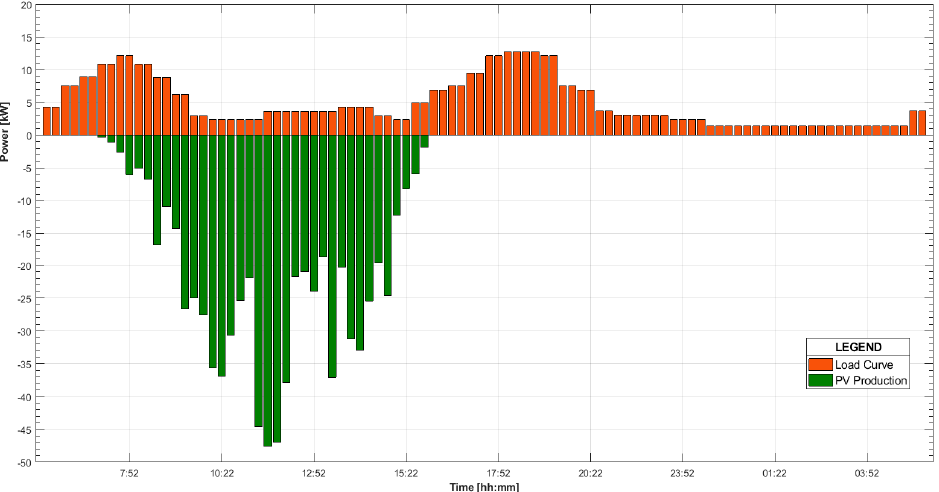
Figure 16. Comparison of load curve of the car park and PV production distributions.